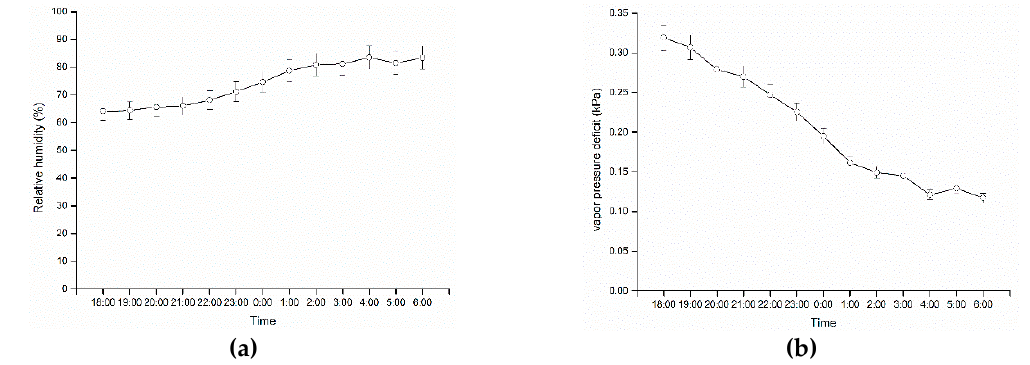
Figure 5. The variation of relative humidity and vapor pressure deficit during typical night (( a ) the variation of relative humidity; ( b ) the variation of vapor pressure deficit).